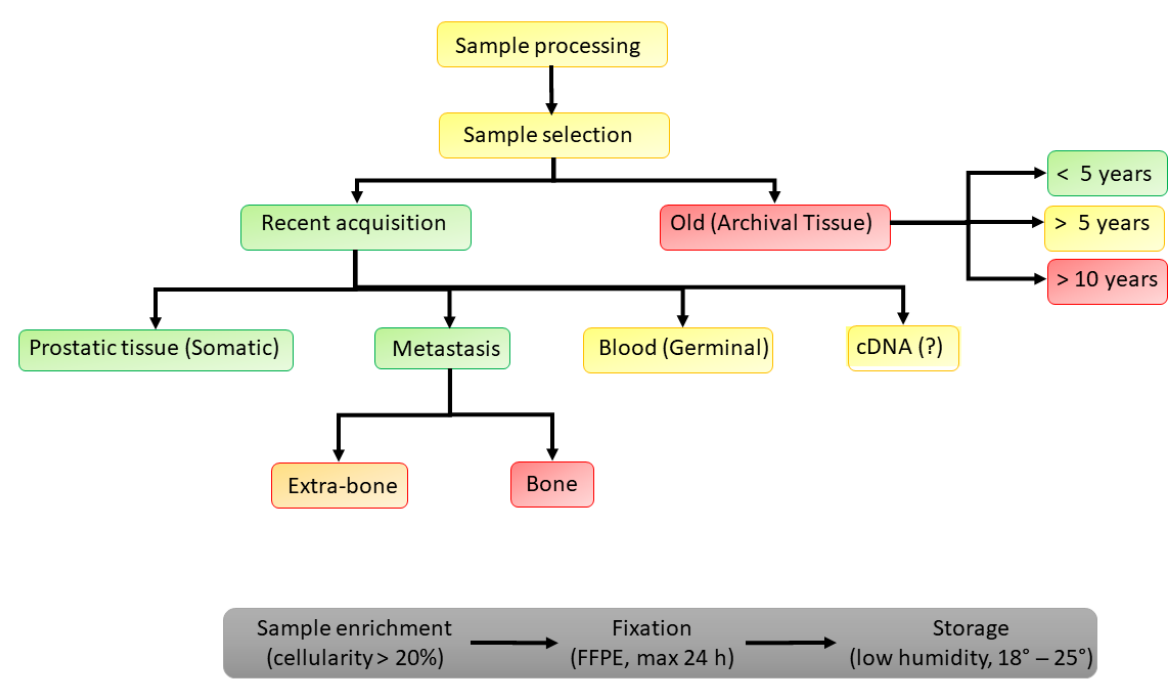
Figure 1. How to detect HRR pathogenetic variants in PC patients (FFPE, formalin-fixed paraffin- embedded).